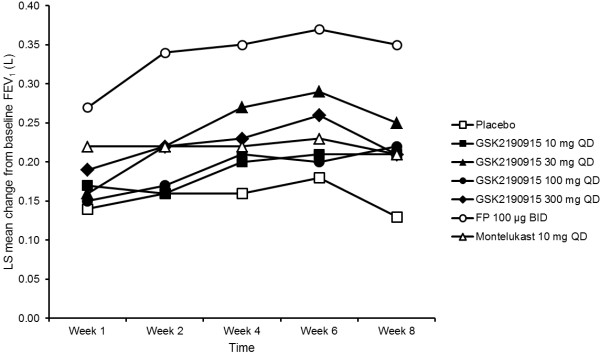
Sensitivity analysis of primary efficacy endpoint. Repeated measures analysis of change from baseline in trough FEV1 (L). LS = least squares.